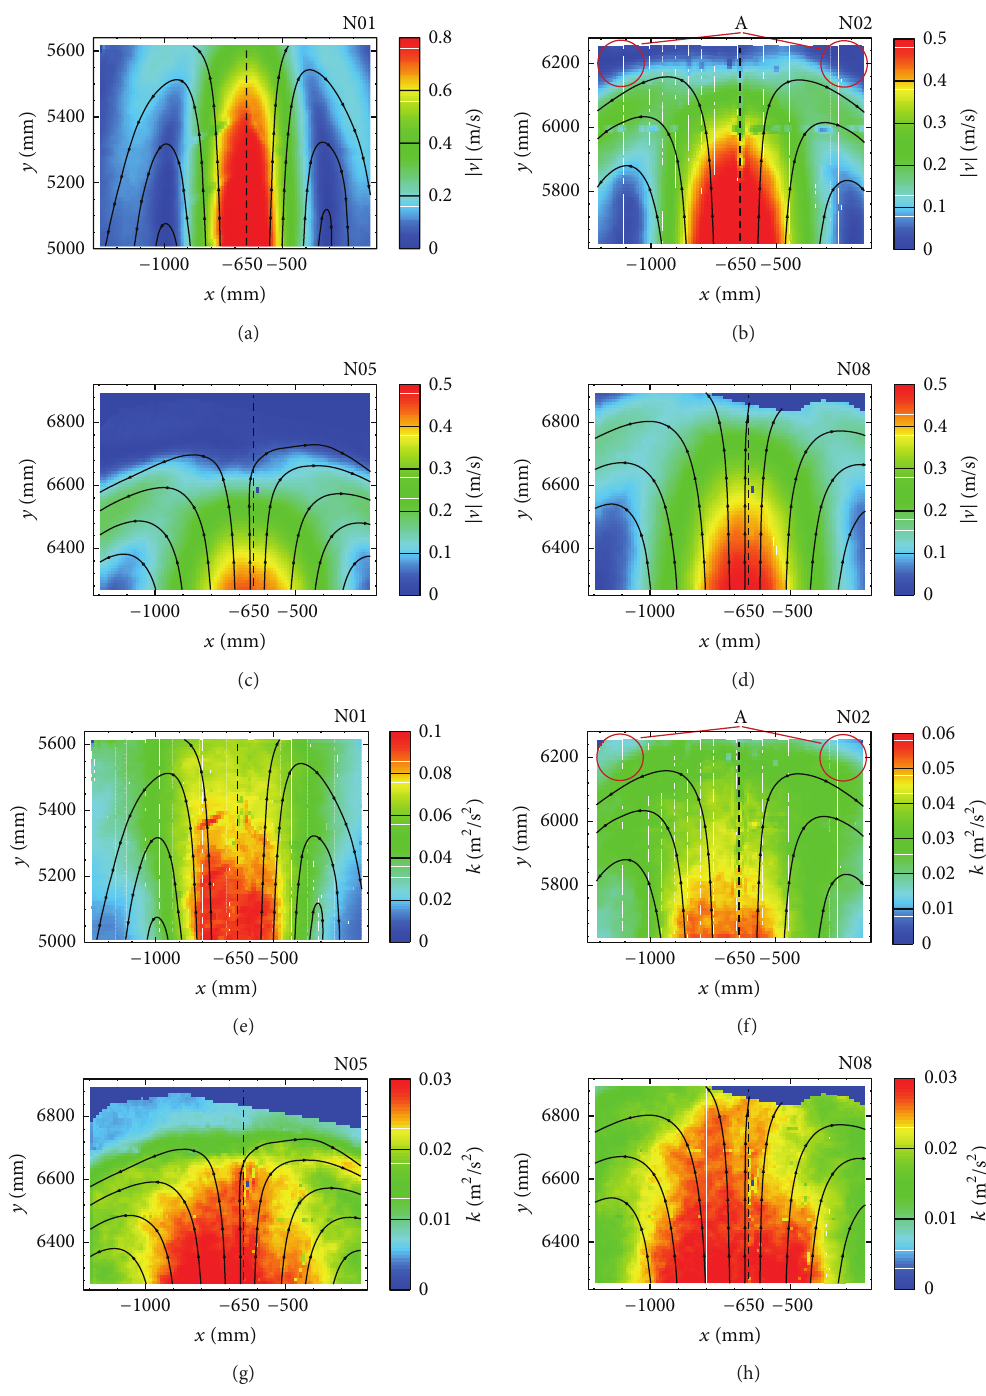
Figure 11: Selected velocity magnitude maps | V | ((a) to (d)) and the corresponding turbulent kinetic energy 𝑘 maps ((e) to (h)) recorded during the erosion process of the helium-rich